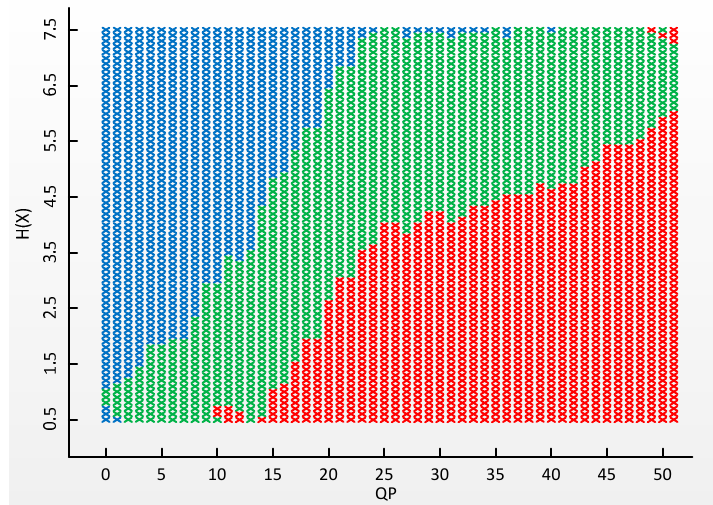
Figure 4. Prediction dictionary of CU partition.